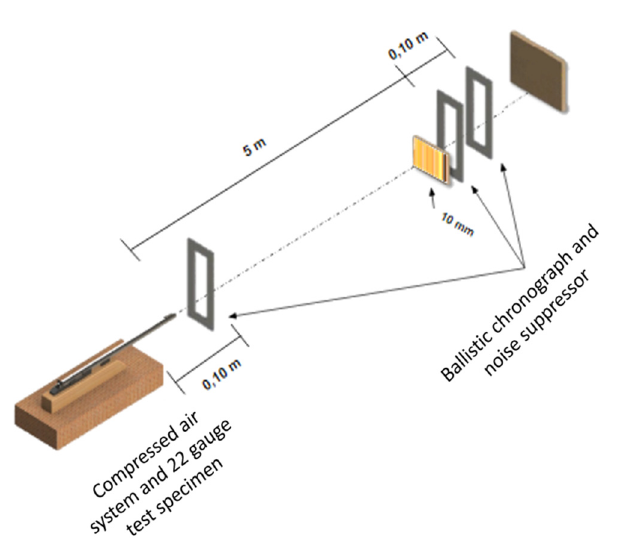
Figure 2. System used in the ballistic test.